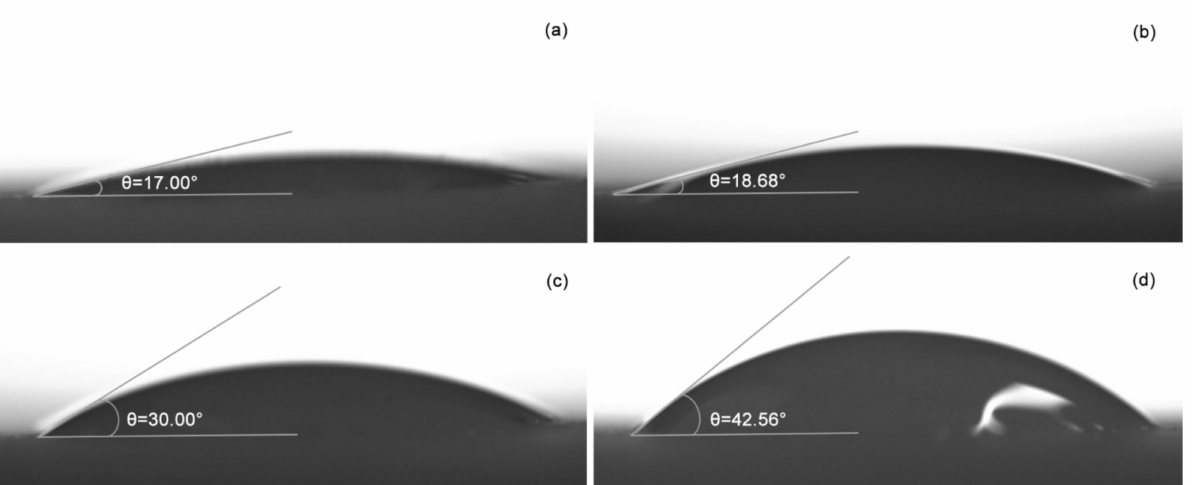
Figure 11. Wetting angles of the specimens with different treatment numbers, ( a ) blank specimen, ( b ) specimen after a single treatment, ( c ) specimen after two treatments, ( d ) specimen after three